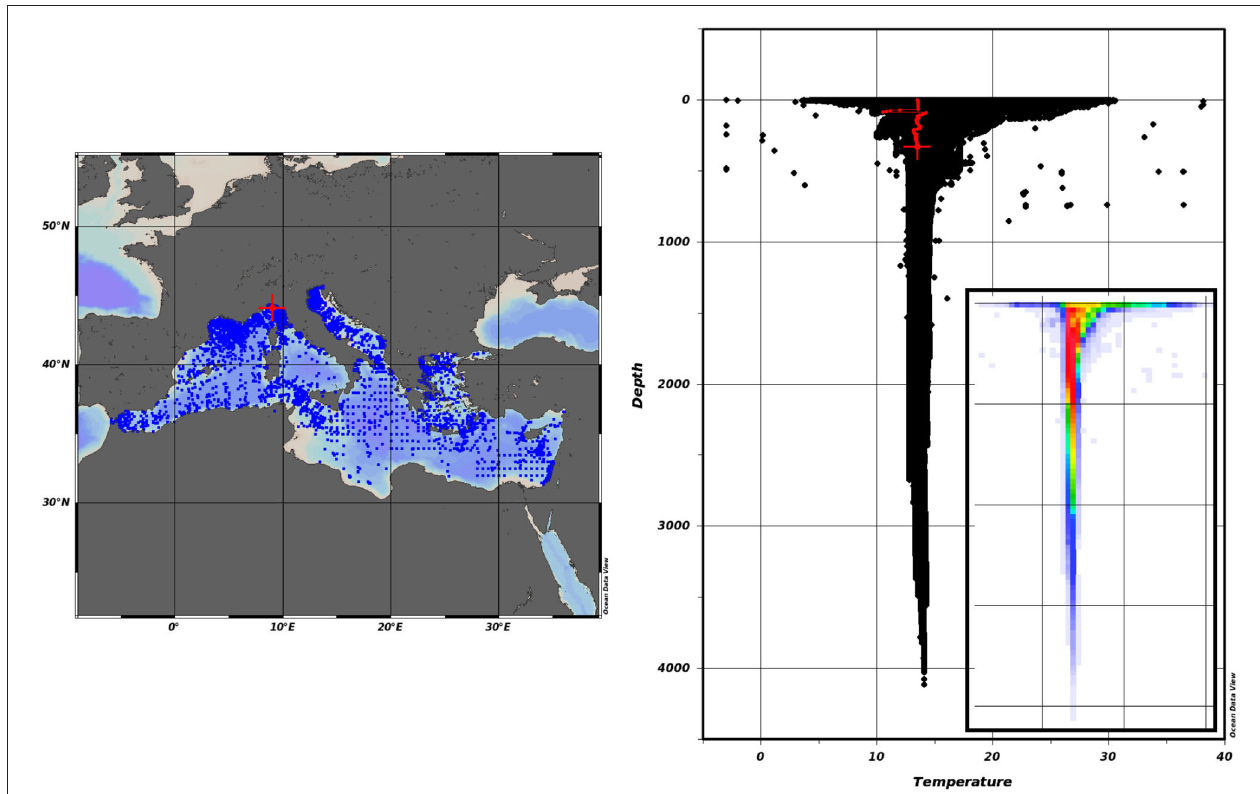
FIGURE 1 | The data subset from the SeaDataCloud Mediterranean Sea data collection. Blue points (9,293) on the map indicate the observed stations. The right scatter plot shows the strongly overlapping of more than 2,000,000 temperature measurements. The red line depicts a typical profile in the cloud containing good as well as bad data. The bottom right inlay figure shows the density of the